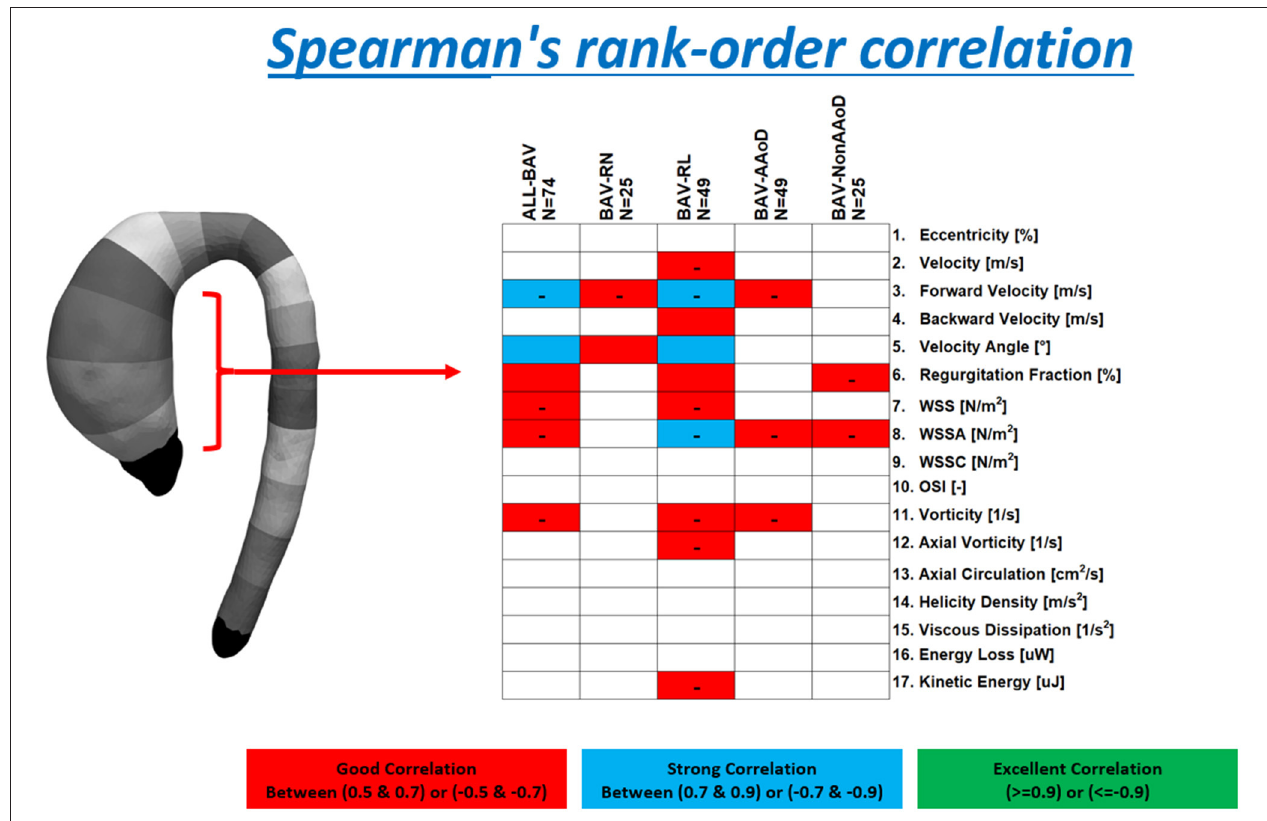
FIGURE 5 | Spearman’s correlation coefficient values for patients with BAV, BAV-RN, BAV-RL, BAV-AAoD, and BAV-Non-AAoD are reported. These values were grouped as good correlation (red box, Spearman’s correlation between | 0.5 | and | 0.7 | ), strong correlation (blue box, Spearman’s correlation between | 0.7 | and | 0.9 | ), and excellent correlation (green box, Spearman’s correlation above | 0.9 | ). The minus sign indicates a negative